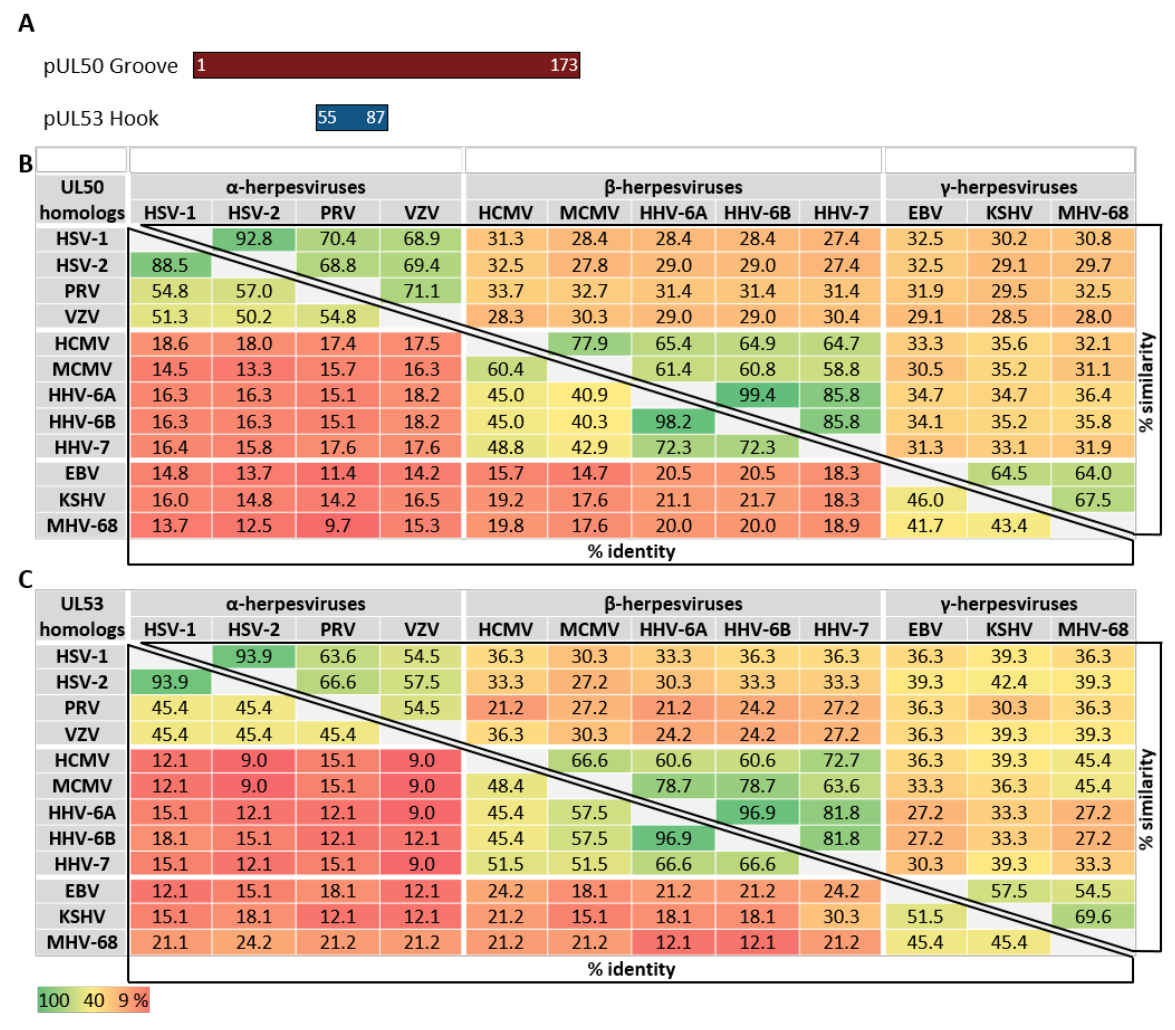
Figure 4. Amino acid sequence identities and similarities in % of the pUL50 groove- and pUL53 hook-specific segments of nine human and three animal herpesviruses. ( A ) Schematic depiction of the pUL50 groove and pUL53 hook. Amino acid positions are represented by numbers. ( B ) Homologs of HCMV pUL50 (groove proteins). ( C ) Homologs of HCMV pUL53 (hook proteins).